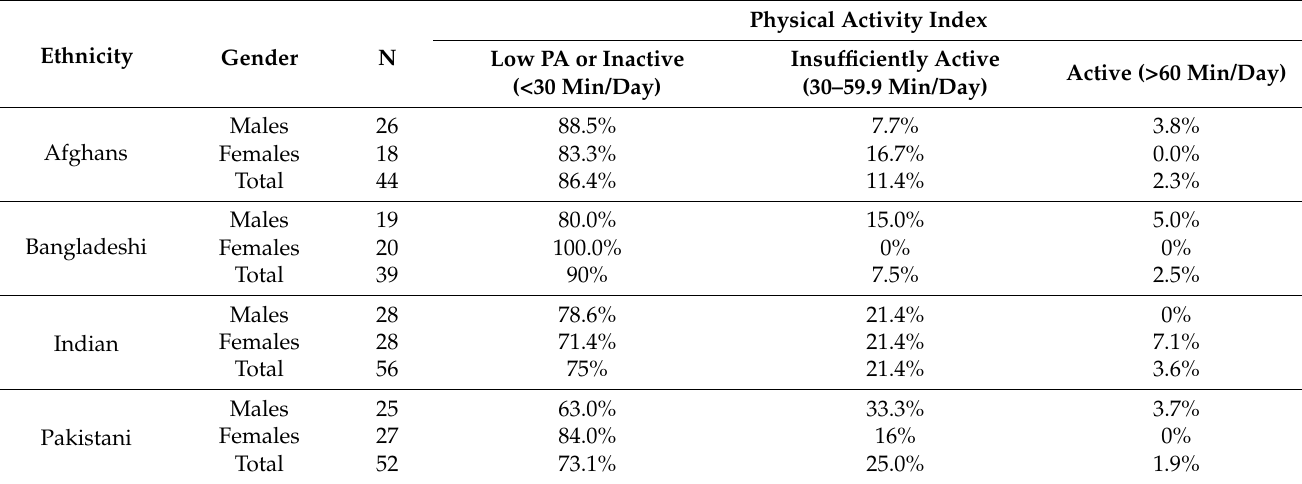
Table 4. Levels of PA of males and females across the four ethnic groups.